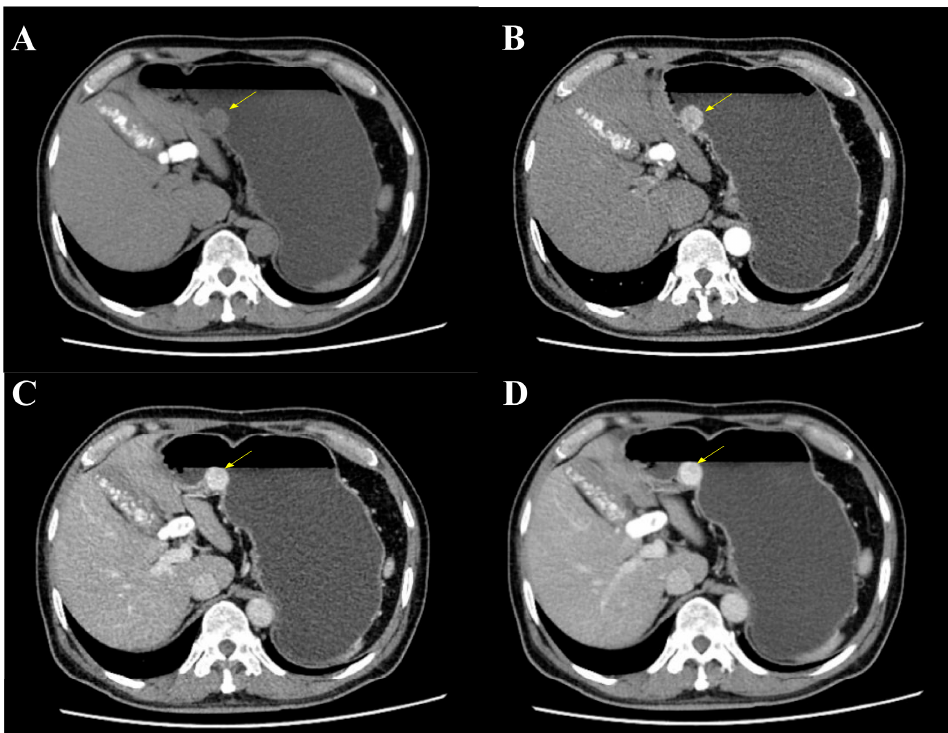
Figure 2. Abdominal and pelvic enhanced CT. ( A ) CT showed a mass at the gastric body with a clear boundary and soft tissue density (yellow arrow). ( B ) The mass was enhanced during arterial phase (yellow arrow). ( C ) An increased enhancement of the mass was found during portal venous phase with a maximum CT value of 156HU (yellow arrow). ( D ) The mass was still enhanced during delayed phase (yellow arrow).